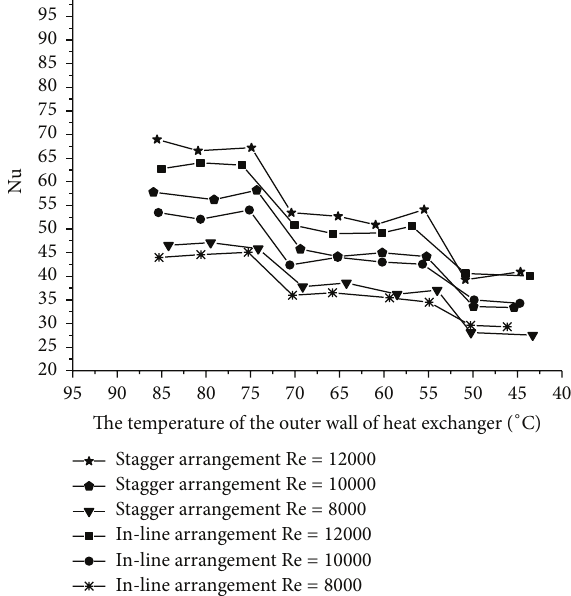
Figure 6: Changing regulation of Nu with respect to the tempera- ture of outer wall in experiment